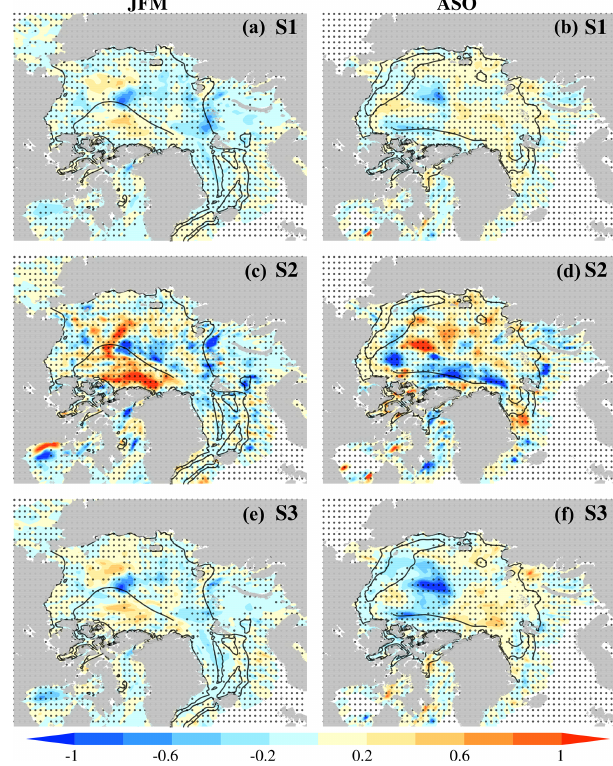
Figure 11. Trend relative to the number of sea ice categories in pointwise temporal correlation coefficients between simulated and observed Arctic SIC anomalies (in [number of categories] − 1 ) in the (a, b) S1, (c, d) S2, and (e, f) S3 discretizations in (a, c, e) JFM and (b, d, f) ASO. An average between results in OSI SAF, NSIDC, and HadISST is shown. Values are multiplied by 100 to ease the interpretation and the color shading is adapted for a better view of the values between − 1 and 1. A value of 0.5, for example, indicates that the model–data correlation coefficient increases 0.5 when the number of categories increases by 100 (or 0.25 for an increase of 50 categories). Stippling masks trend values which are statistically nonsignificant at the 5% level based on a two-tailed Student’s t test. Contours are the simulated climatological ice thickness (every 1.5m) in the standard LIM3 discretization of five categories (S1.05) for the period